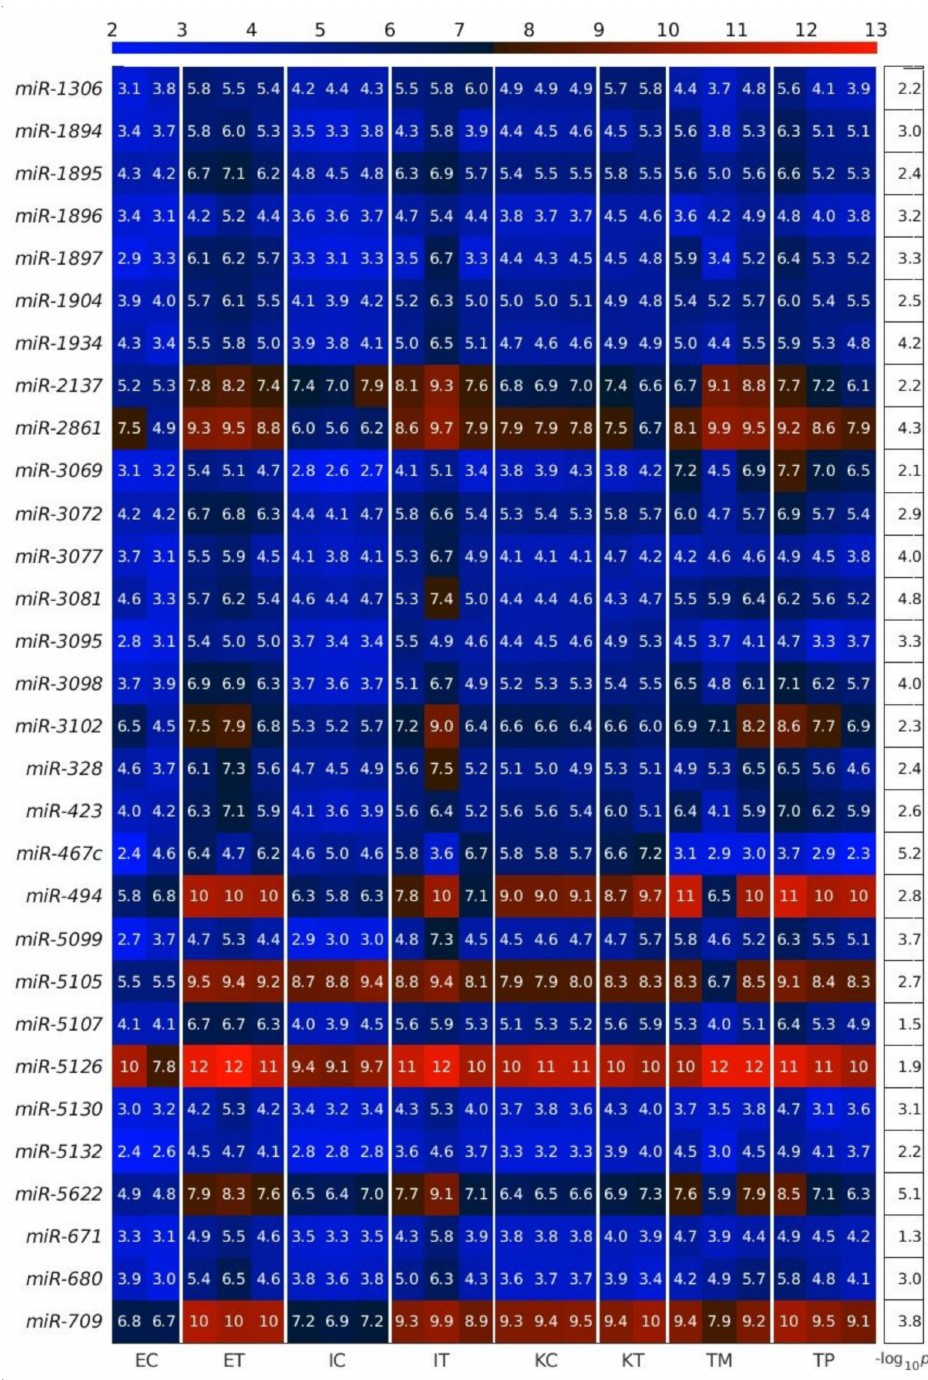
Figure 4. Upregulated miRNAs between the control and the tumor microenvironment (TME) cells. Heatmap of the expression of the differentially expressed miRNAs (DEMs) in lexicographic order of the miRNA names. The color bar codifies the miRNA expression in log 2 scale. Higher miRNA expression corresponds to redder color. The − log 10 ( p -value) of the DEMs are presented in a table to the right of the heatmap. The samples are denoted with E, I and K for endothelial, Ito and Kupffer cells, C and T for the control and the TME cells, and TP and TM for colorectal cancer (CRC) primary and liver metastasis cells,